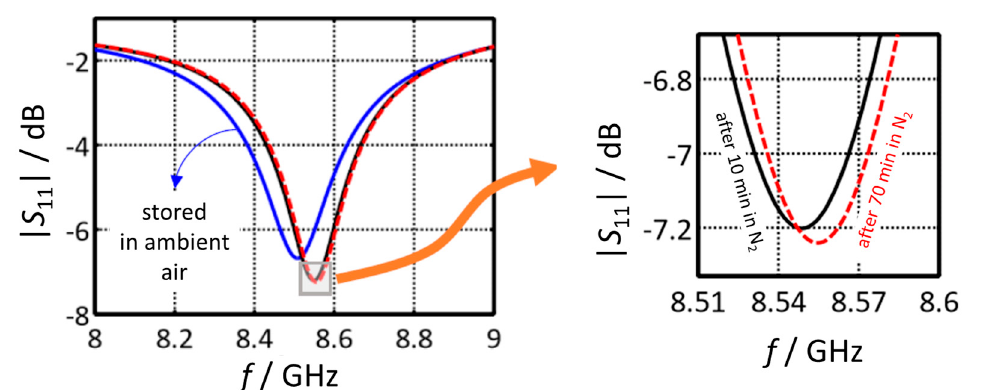
Figure 3. Typical resonance spectra of the device shown in Figure 2. The blue curve denotes a spectrum of a sensor after storage in air. The black and the red curve were recorded after purging with nitrogen.